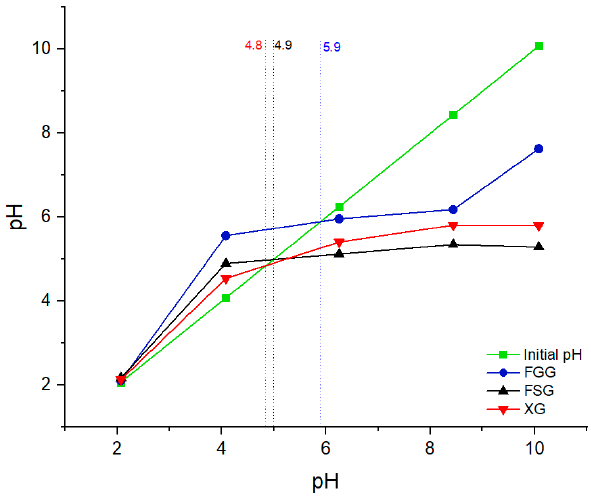
Figure 4. Zero-point-charge (pH pzc ) as a function of variable initial pH for FSG, FGG and XG.